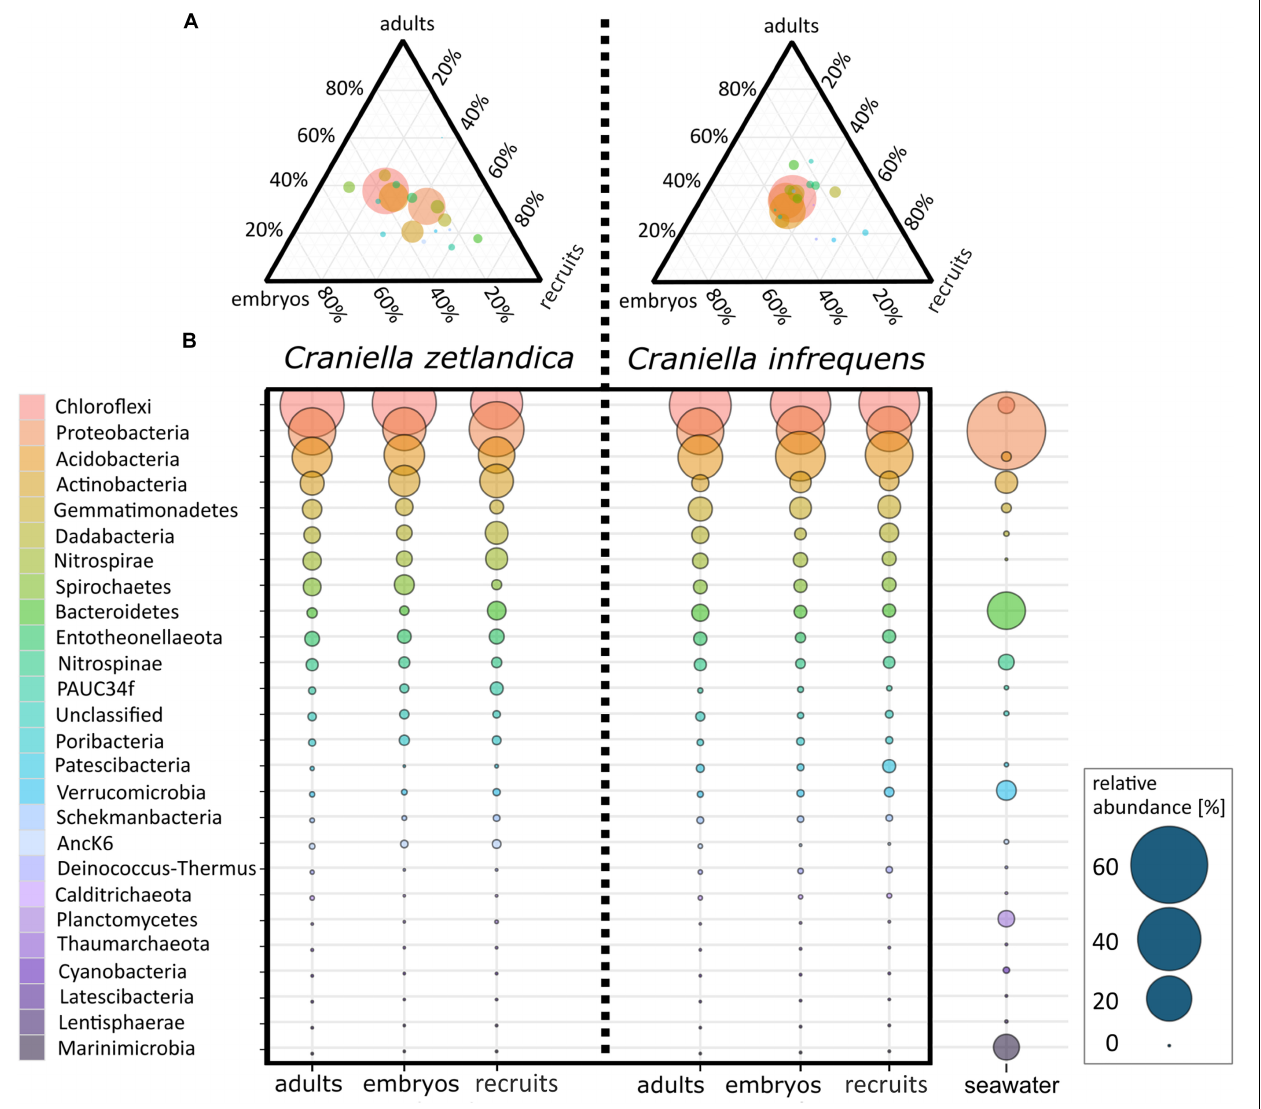
FIGURE 5 | (A) Ternary plot of average prokaryotic phyla distributions for embryos, recruits, and adults of C . zetlandica and C . infrequens . Colors of phyla are the same in both figures: (A,B) . Circle size indicates relative abundance of respective phyla. (B) Average prokaryotic community composition of C . zetlandica and C . infrequens developmental stages as well as seawater. Microbial phyla are sorted in descending order by mean relative abundances. Circle size indicates relative abundances (for exact relative abundance values consider the scale presented at the right bottom).